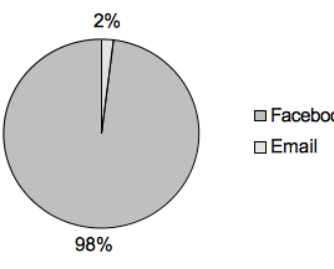
Figure 9. Most accessed account: Facebook versus e-mail.